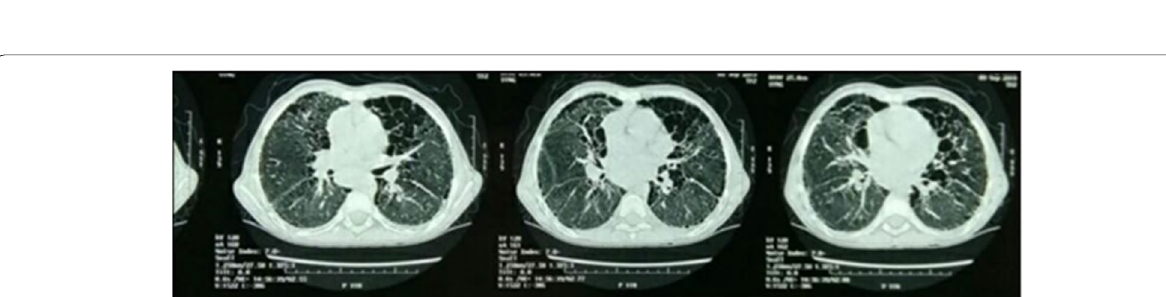
Fig. 3 Ground glass appearance, peribronchial thickening, and cyst formation bilateral (HRCT patient number 5)